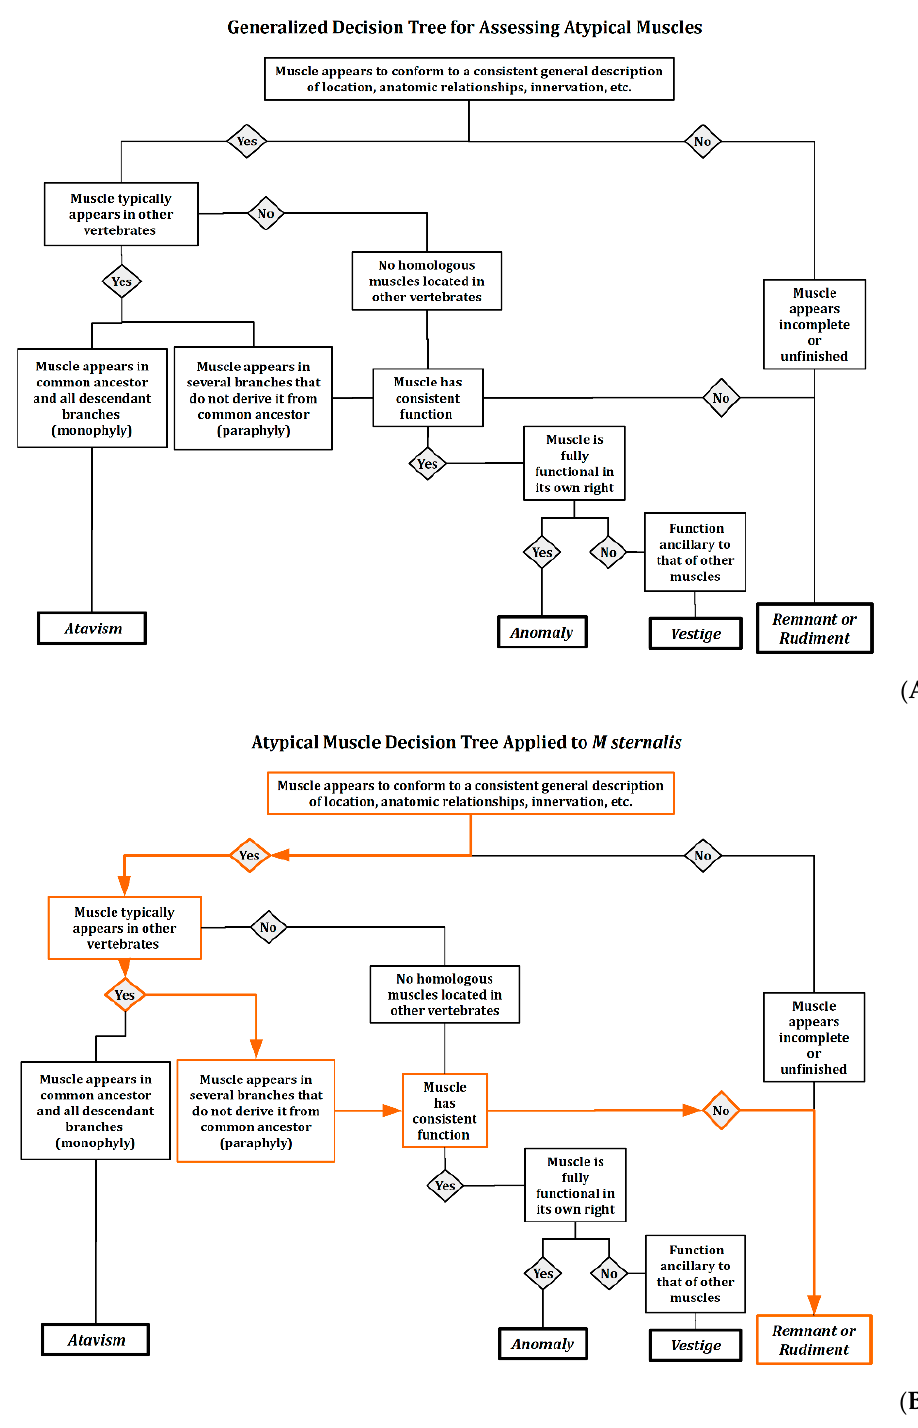
Figure 5. Decision Tree for assessing the likely sources of anatomic variations and areas for further inquiry. ( A ) Generalized form of decision tree showing nodes and links among pathways; ( B ) Application of decision tree to this particular example of M sternalis showing the realized decision pathway in orange .